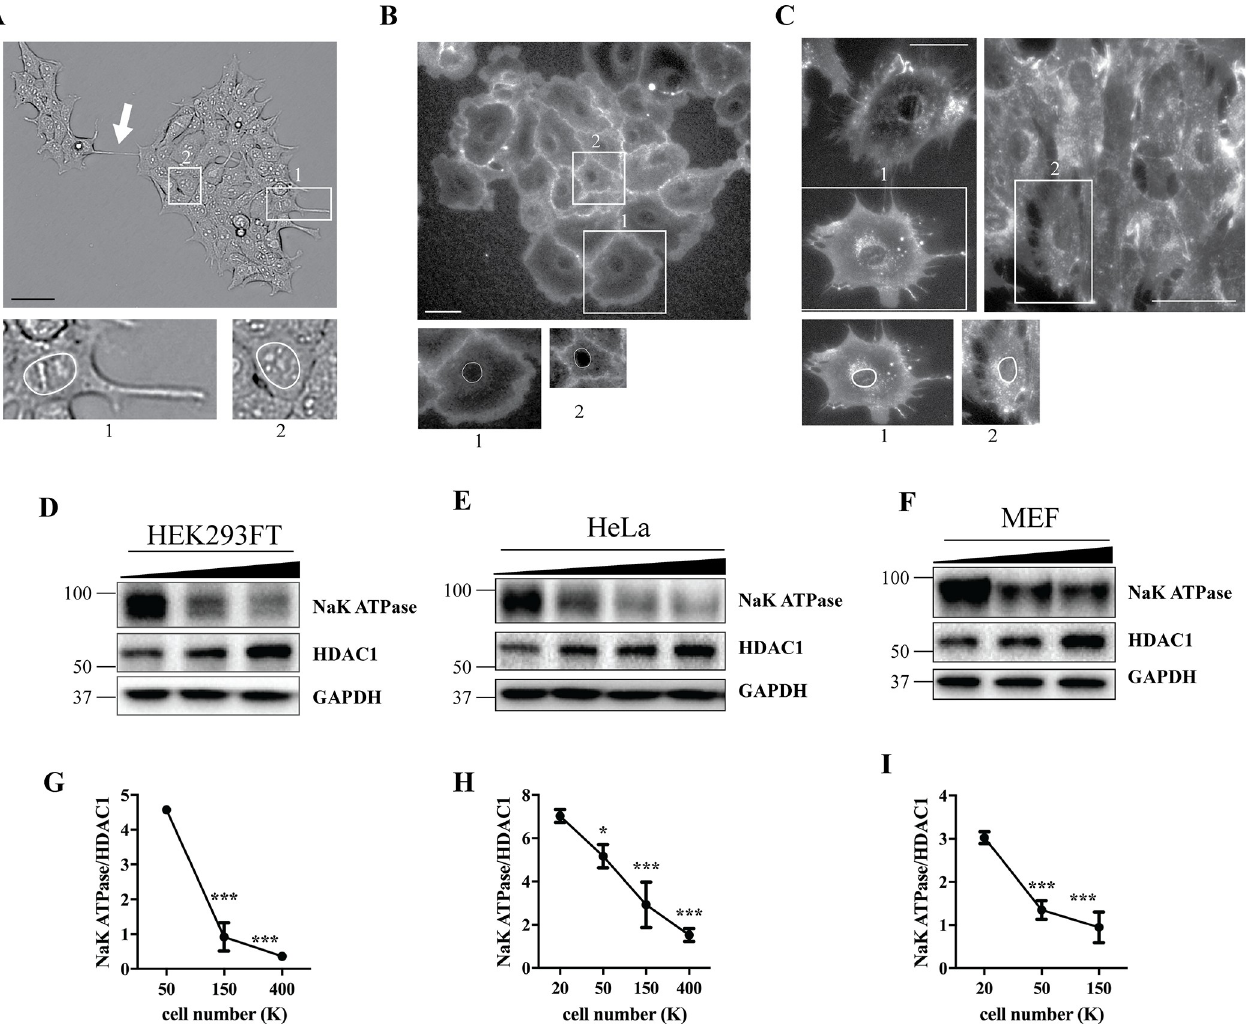
Fig 5. Allometric scaling of the plasma membrane and the nuclei is reflected in the Western blot analysis. 100K HEK 293FT (A), 50K HeLa (B) or 10K (C, left) and 200K (C, right) MEF cells were plated in 6 well plates, incubated for 2d, left unlabeled (A) or labeled with WGA (B,C) and imaged using bright field or fluorescent microscopy; 1, edge-cell (A,B) or cell in sparse conditions (C); 2, non-edge cell (A,B) or cell in crowded conditions (C); arrow in (A) points to a tunneling nanotube. Scale bar, 50 μ m. (D-F) HEK 293FT, HeLa and MEF cells were plated at a range of densities. Cell lysates were analyzed by Western blotting using indicated antibodies. GAPDH was used as a loading control. (G-I) Western blot images were quantified and the Na + K + -ATPase to HDAC1 ratios plotted on the diagrams. N = 3; Line graph data are mean ± SD. � p < 0.05, �� p < 0.01, ��� p < 0.001, relative to 50K (G), or 20K (H,I).